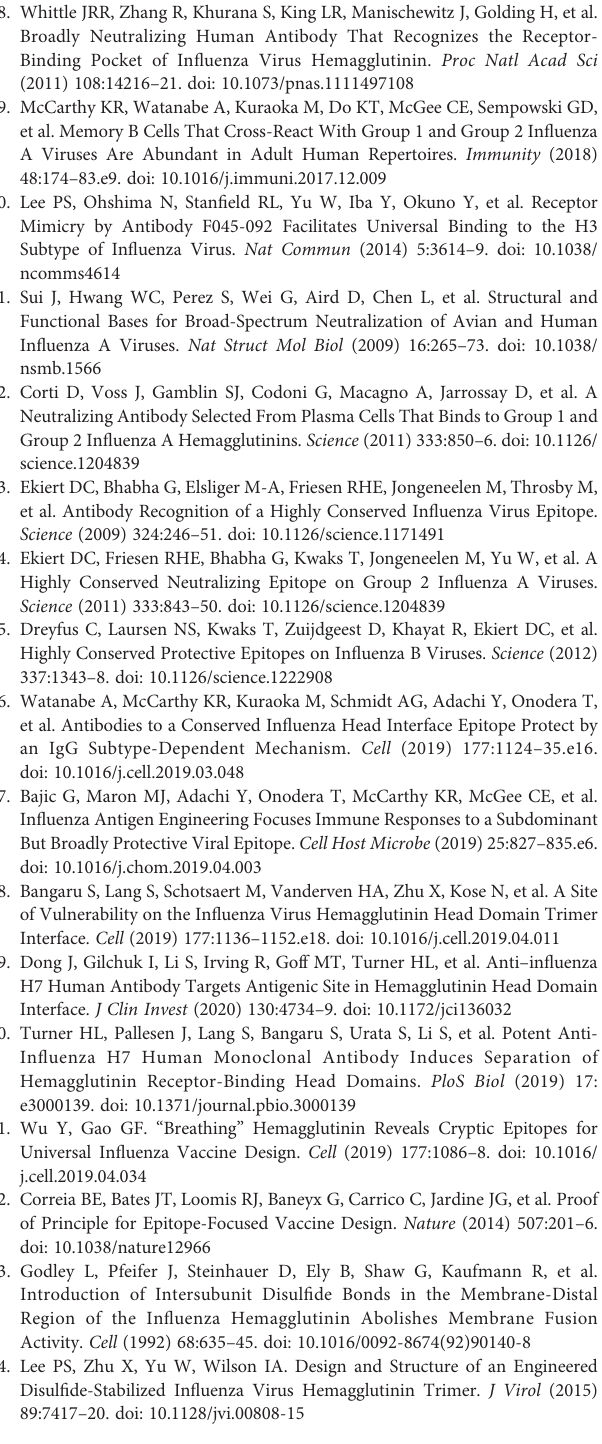
(open circle) and day 28 (closed circle) serum from each individual mouse are plotted as background-subtracted MFI for each immunogen. Titles indicate Luminex antigen and X-axis titles indicate immunogens gHA RBSv2.0 (n=6), gHA cysRBSv2.0 (n=5), gHA shield (n=5), and gHA cysshield (n=5). Mean fl uorescence intensity (MFI) signal minus background ± SD is reported; n = number of mice